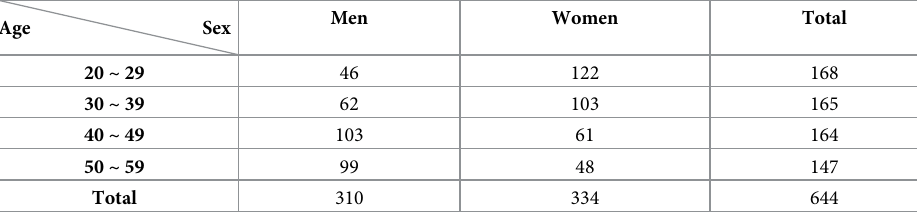
Table 1. The number of participants for each